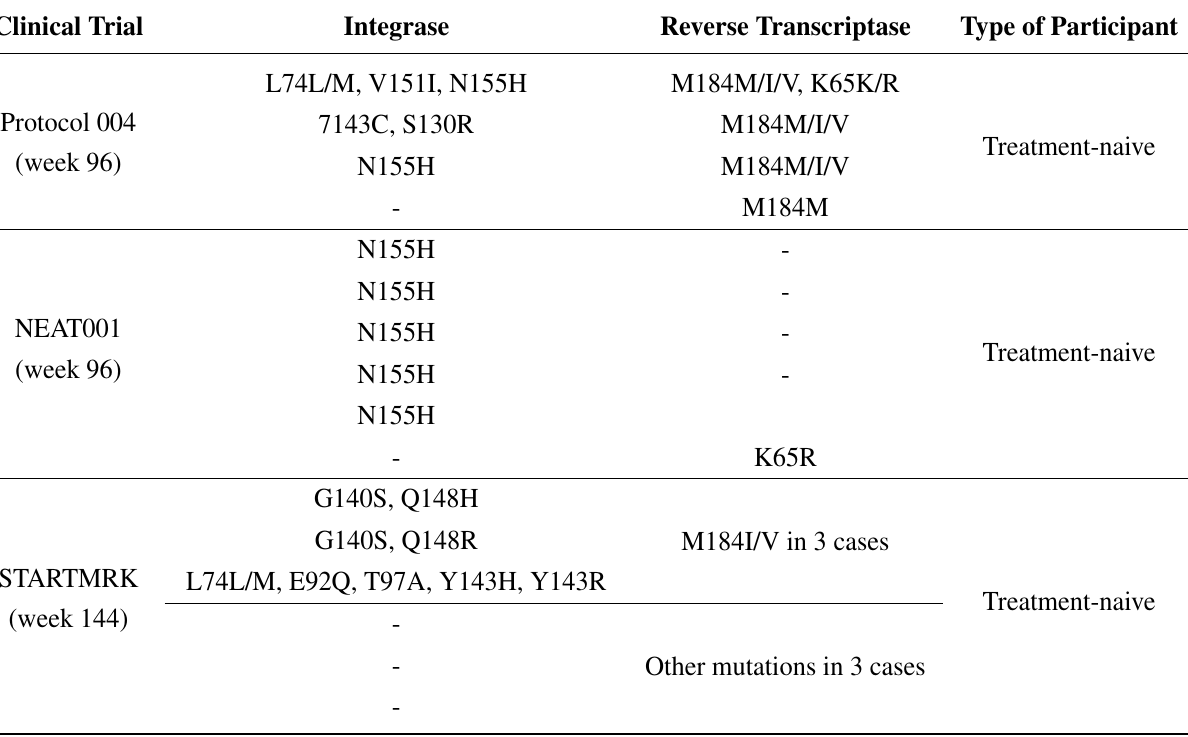
Table 1. Examples of new IN and RT drug resistant mutations emerging after treatment failure with